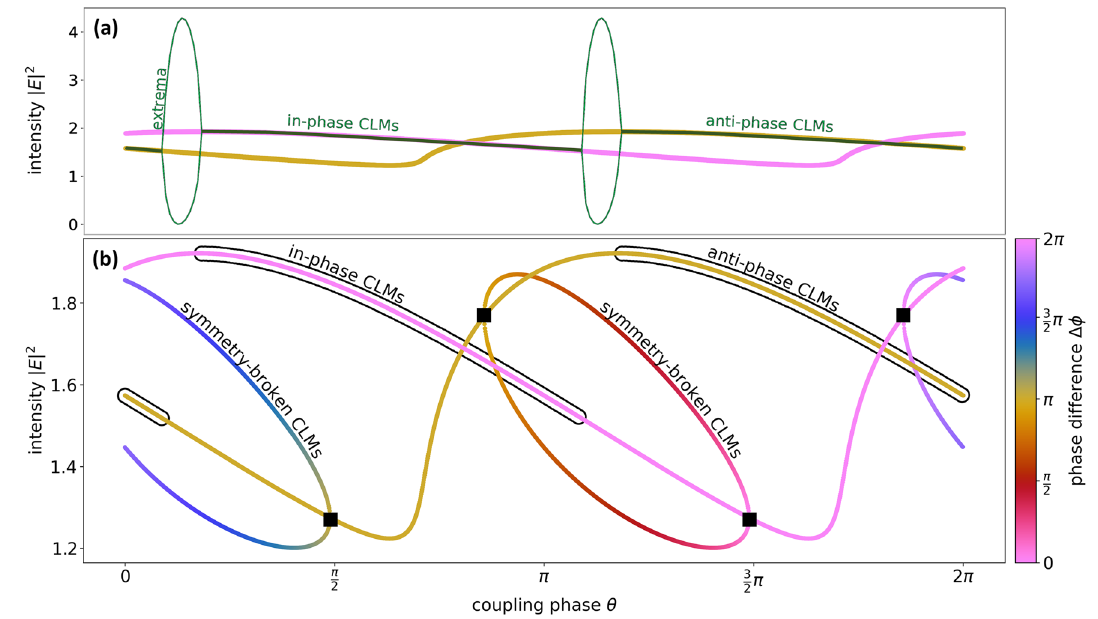
Figure 3. ( a ) Bifurcation scan of laser intensity | E | 2 as a function of the coupling phase (dark green, lasers are identical and emit the same intensity), yellow and pink lines show the constant phase CLMs, ( b ) intensity of constant-phase and symmetry-broken CLMs. The line color encodes the phase difference �φ between the electric fields of the two lasers. The black squares denote pitchfork bifurcations 33 . Stable solutions in ( b ) are indicated by black surroundings. Other parameters are T 2 = 2 , �ω = 3 , p = 2 , K = 0.1 , τ = 10 , δω = 0